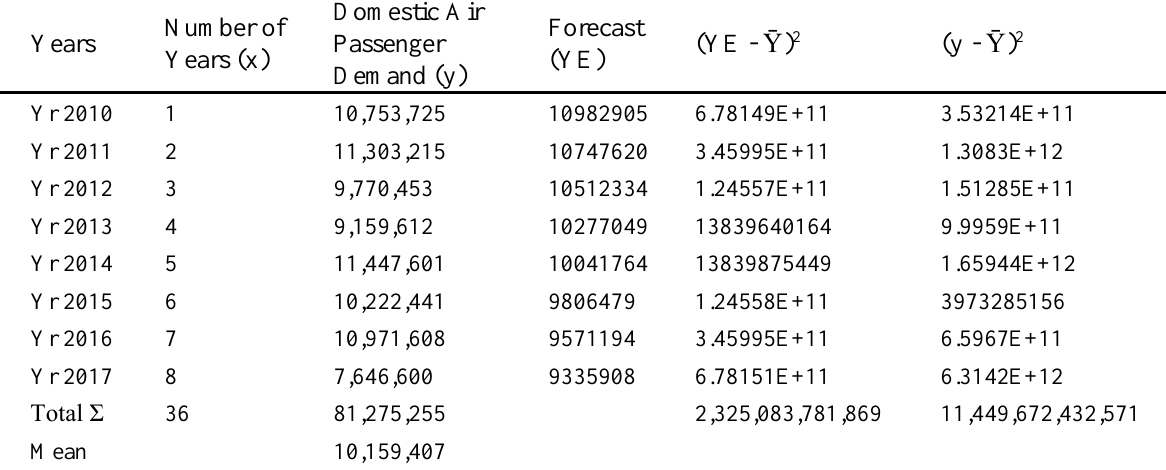
Table 4. Calculation of Coefficient of Determination (R 2